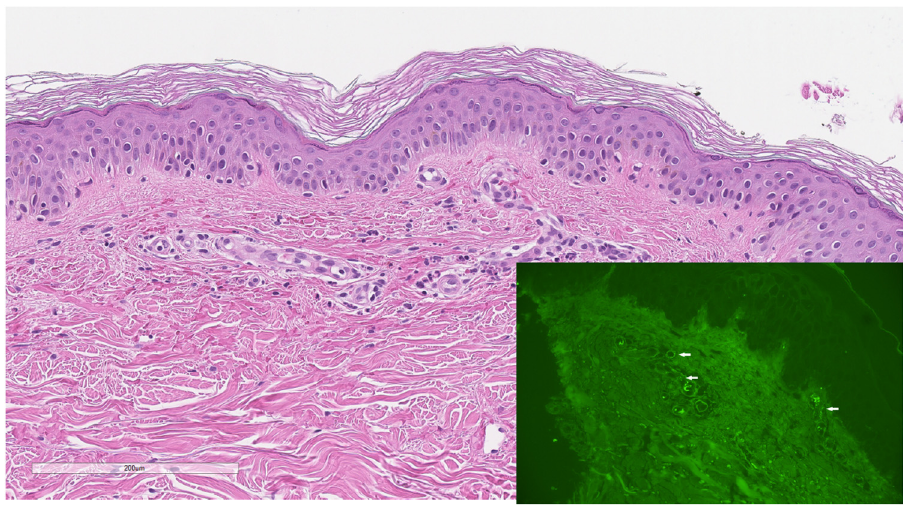
Figure 3: Small vessels oedema of endothelium with perivascular leukocytoclasis, erythrocytes extravasation with focal IgA deposition in the